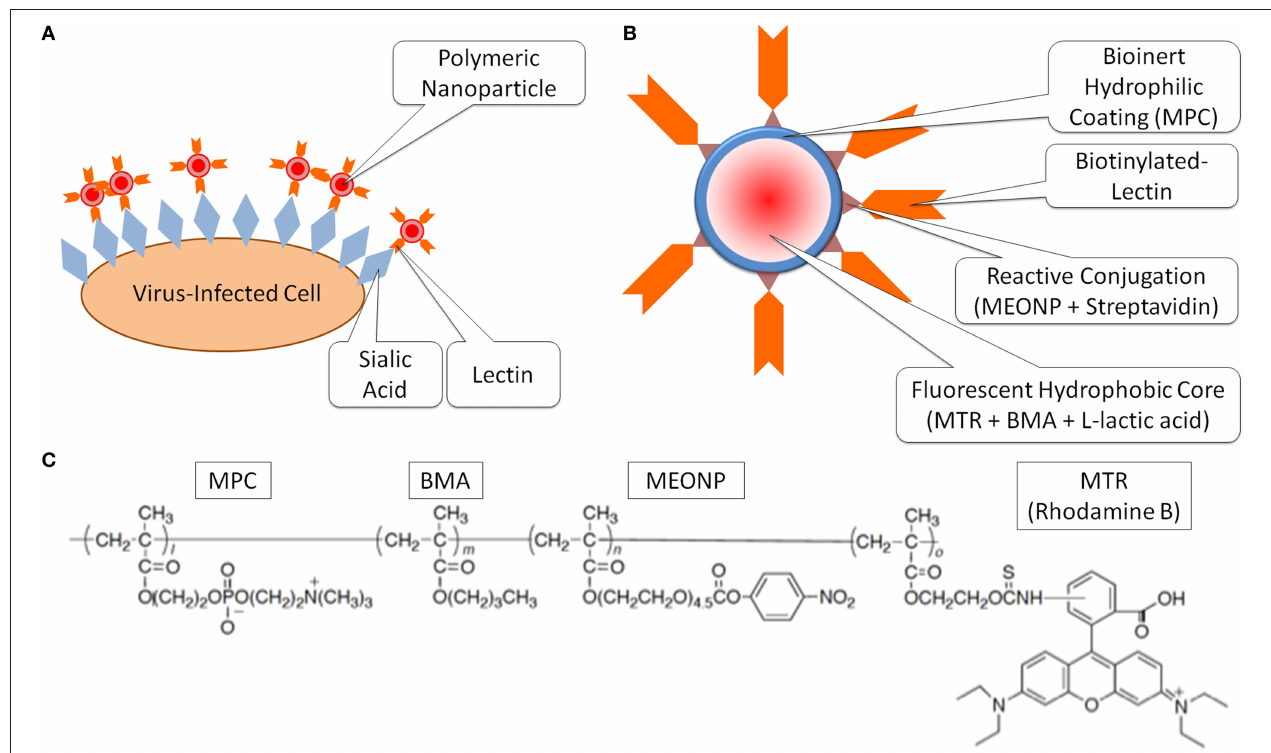
FIGURE 2 | The schematics of the experimental design (A), the design of the nanoprobe to detect sialic acids (B) and the chemical structures of the incorporated functional monomers (C).